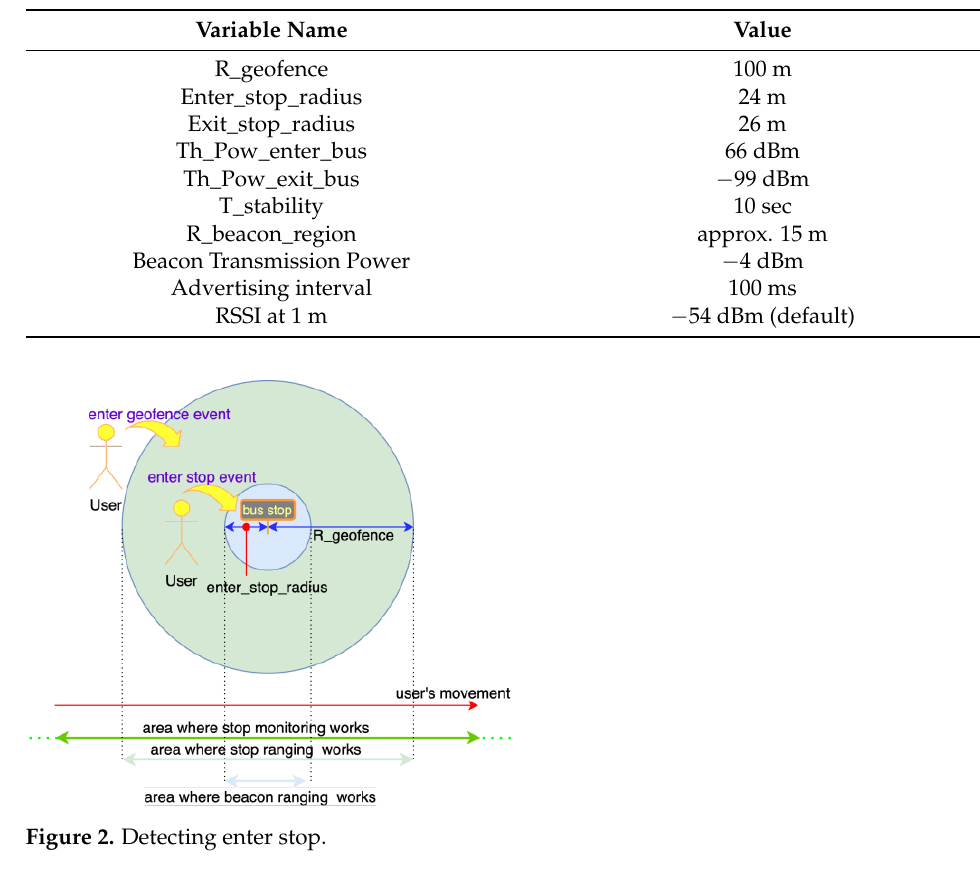
Table 2. System setting variables used during the experimentation.